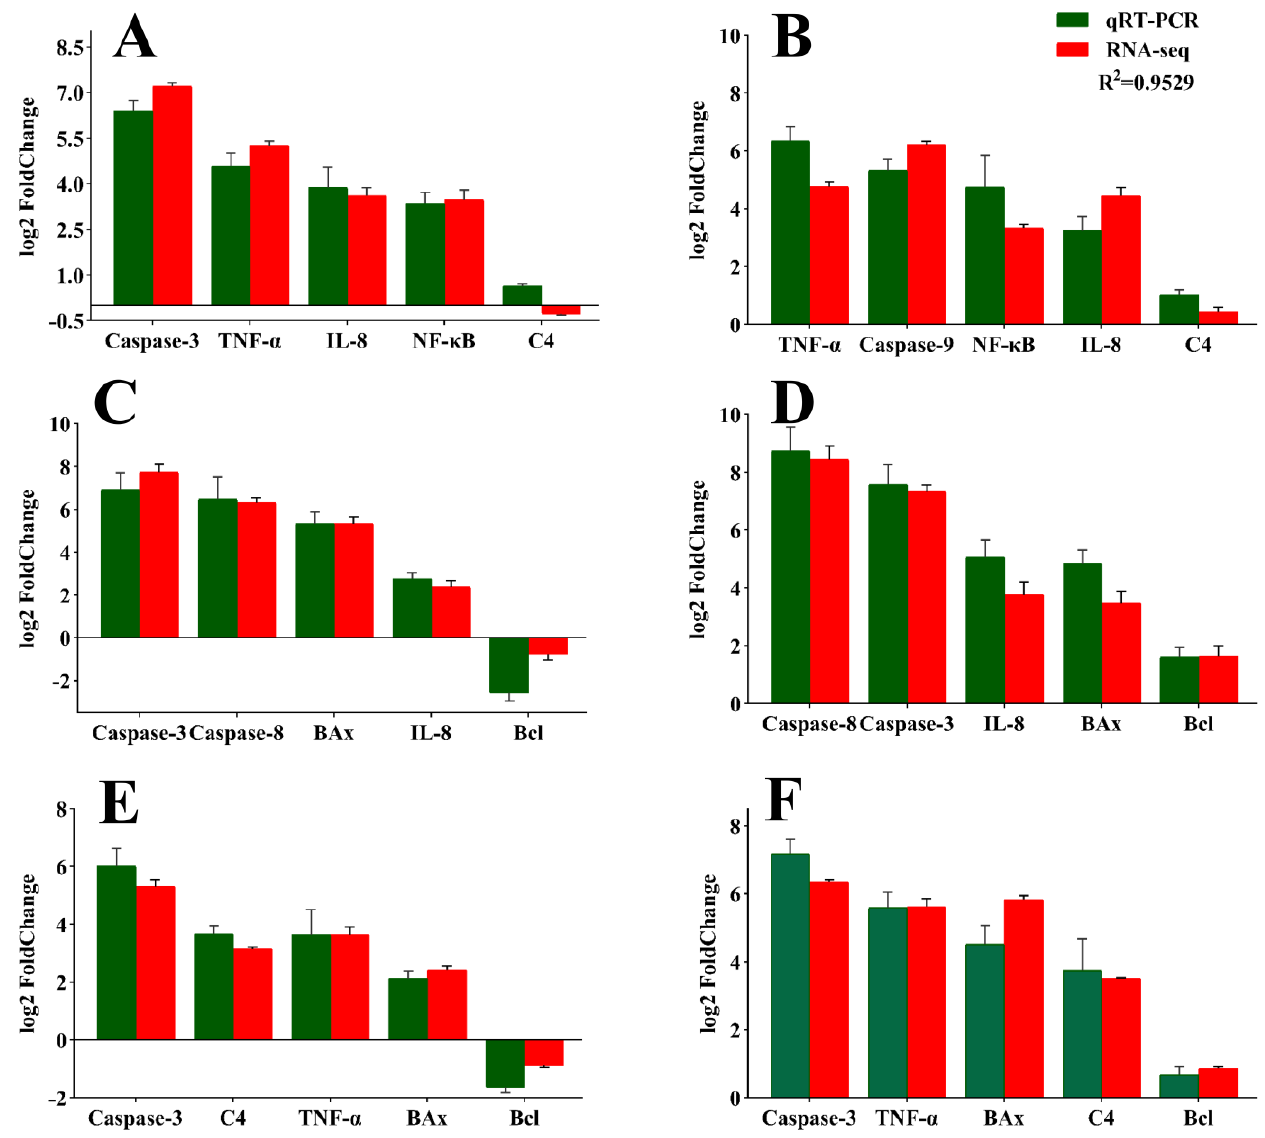
Figure 3. Comparison of the transcriptome sequencing results and qRT-PCR determination of the DEG expression profiles. ( A , C , E ) show the liver, spleen, and head kidney 48 h after infection, respectively. ( B , D , F ) show the liver, spleen, and head kidney 120 h after infection, respectively.